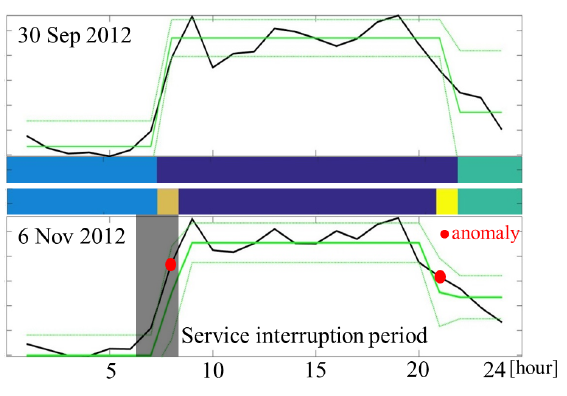
Table 4: Confusion matrix of the result with the synthetic data Result of anomaly detection Figure 7: learning result of training data(upper), anomaly detec- tion result(lower) and compared